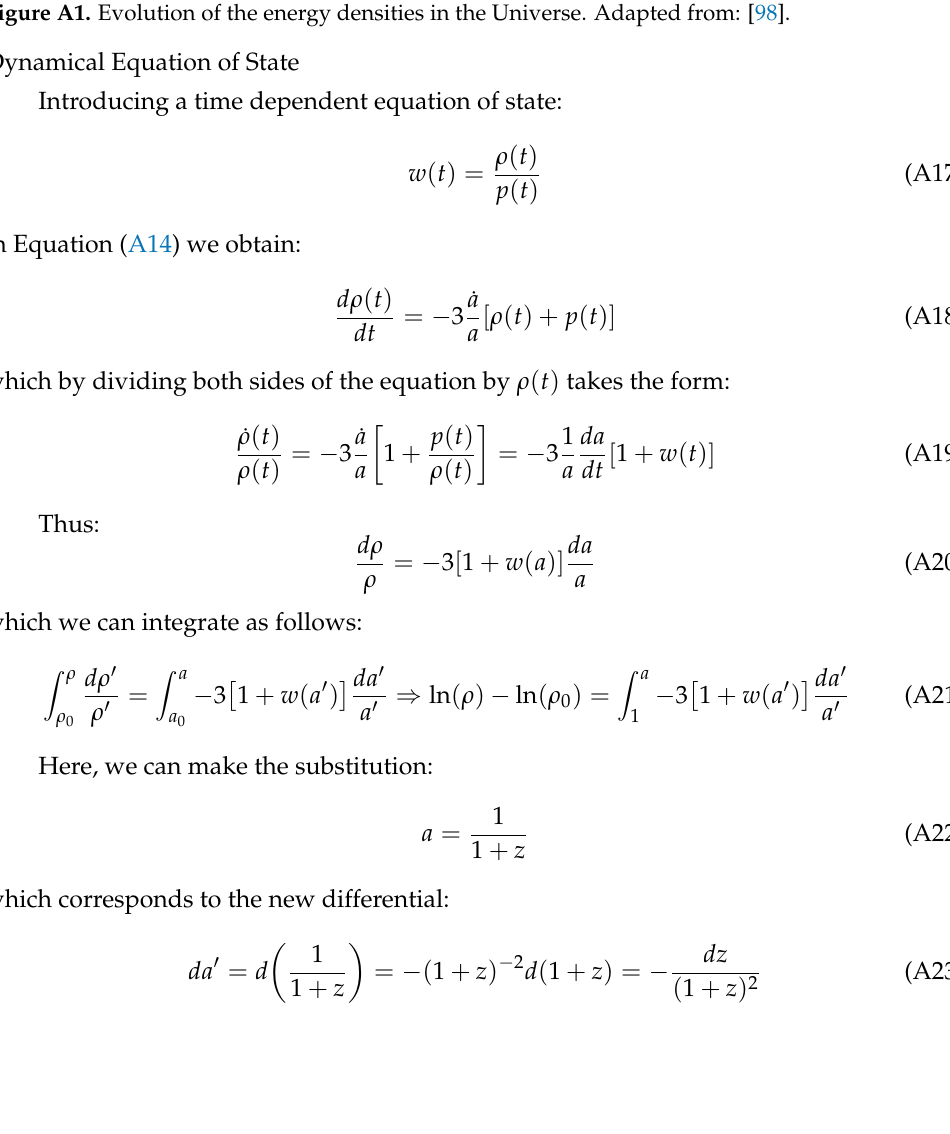
Figure A1. Evolution of the energy densities in the Universe. Adapted from: